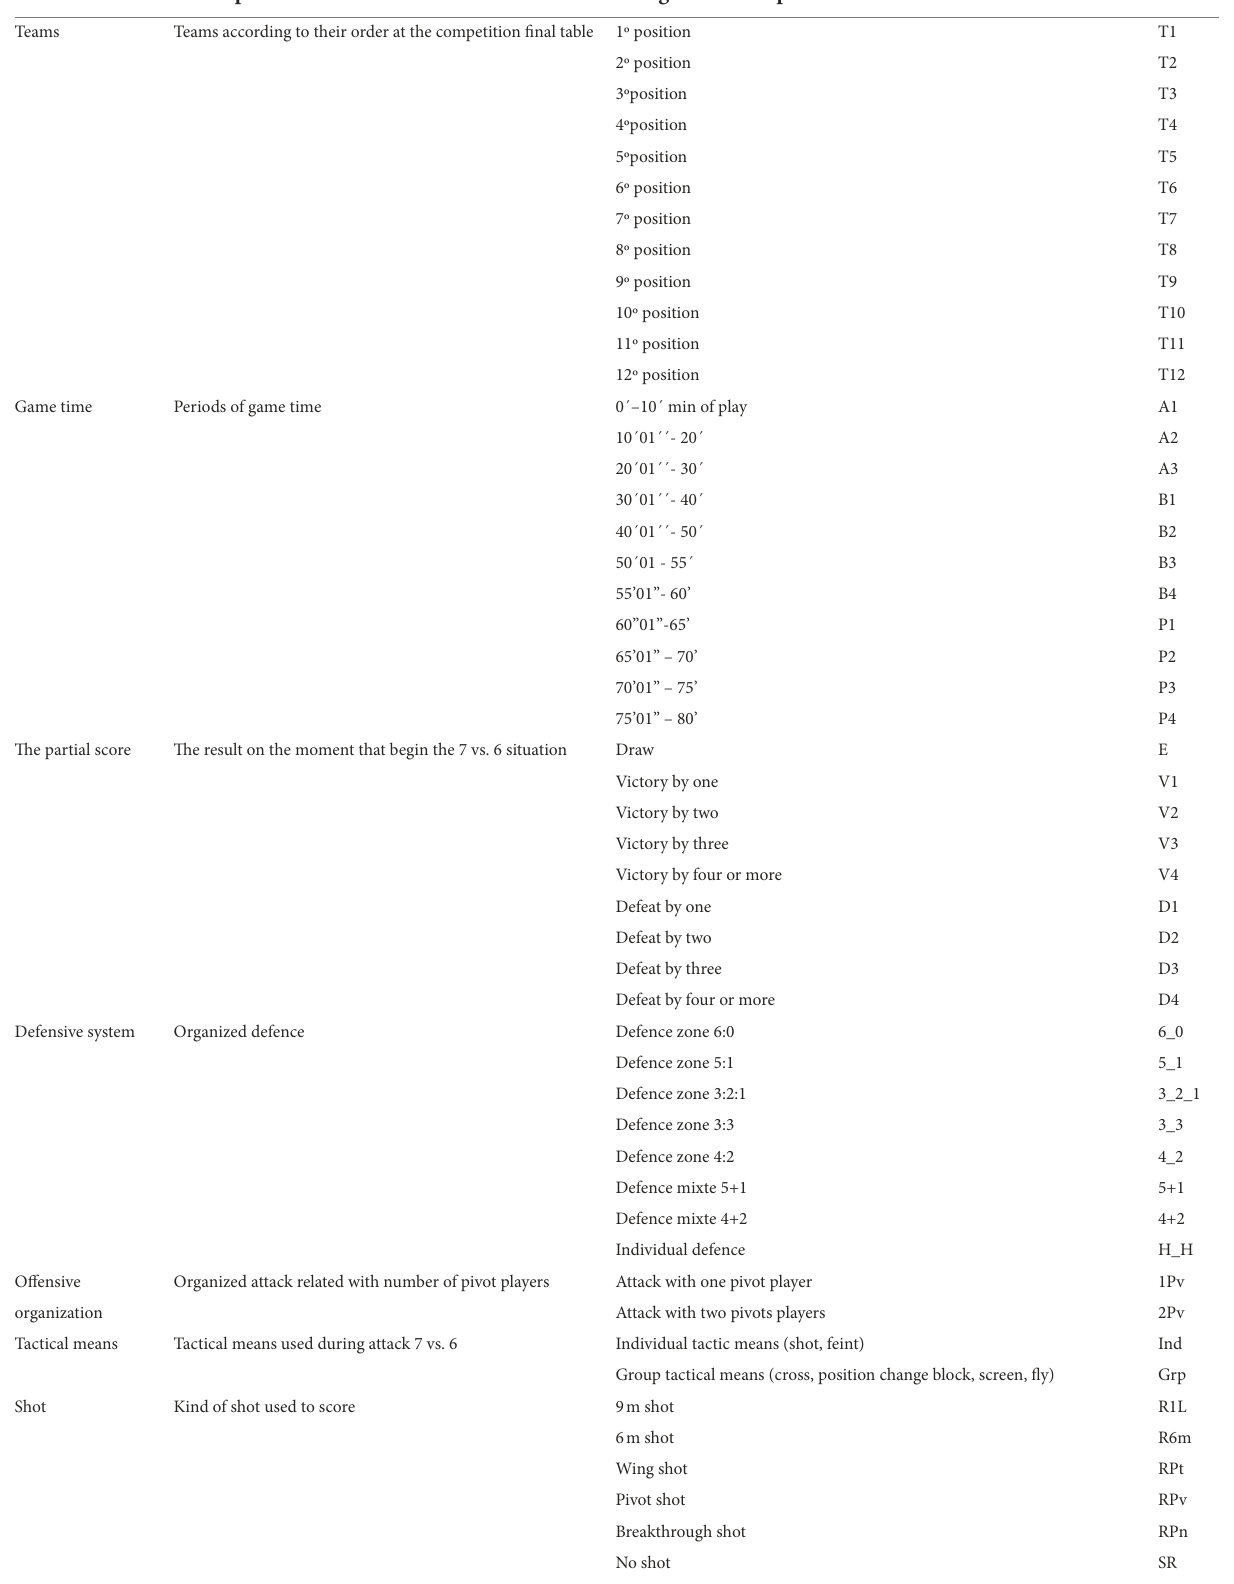
TABLE 1 Observation instrument. Criteria Teams according to their order at the competition final table 1º